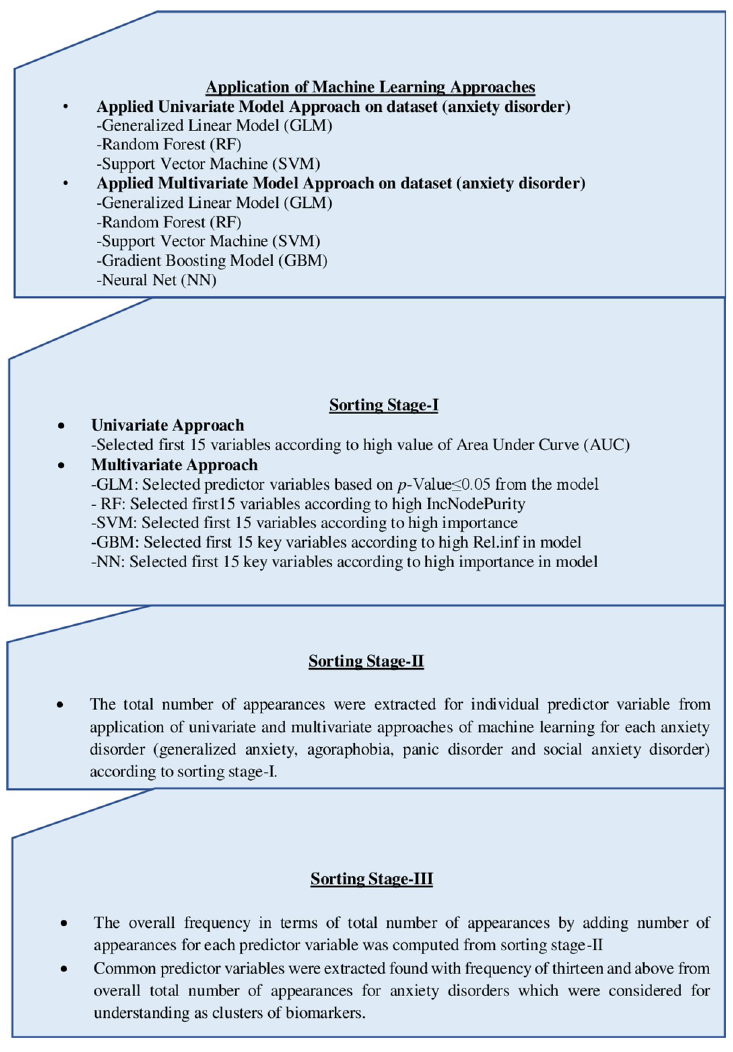
Fig 2. Procedure followed for the study. Authors’ own